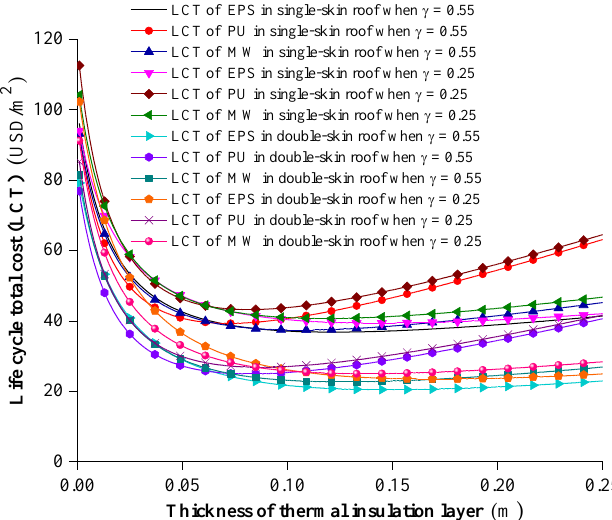
Figure 6. Life cycle total investment of roof thermal insulation.